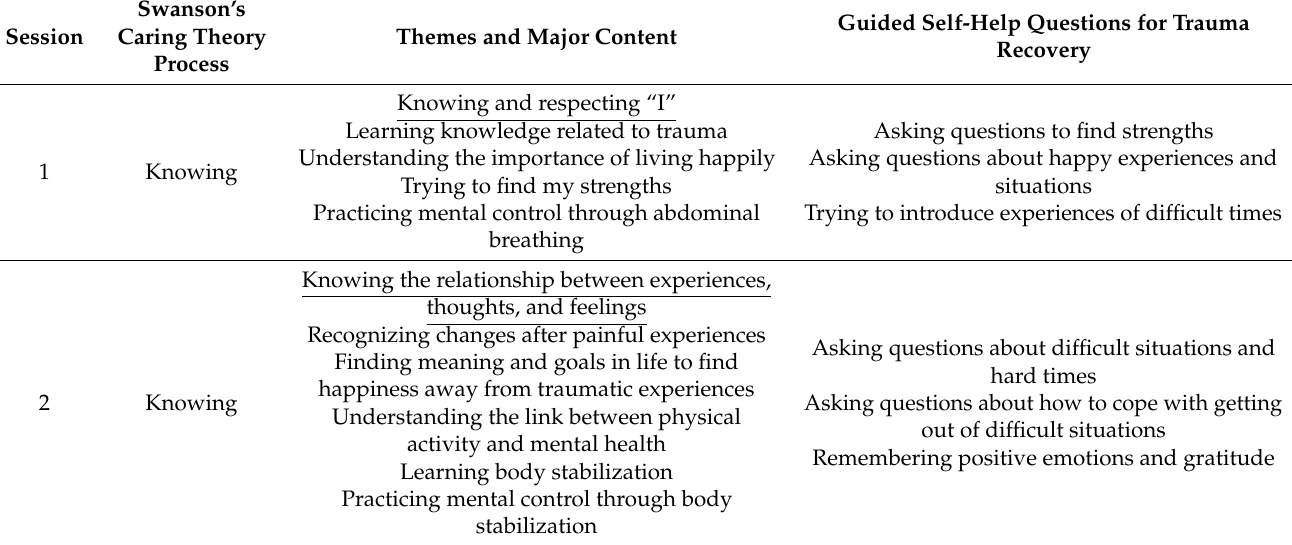
Table 2. The eight-session